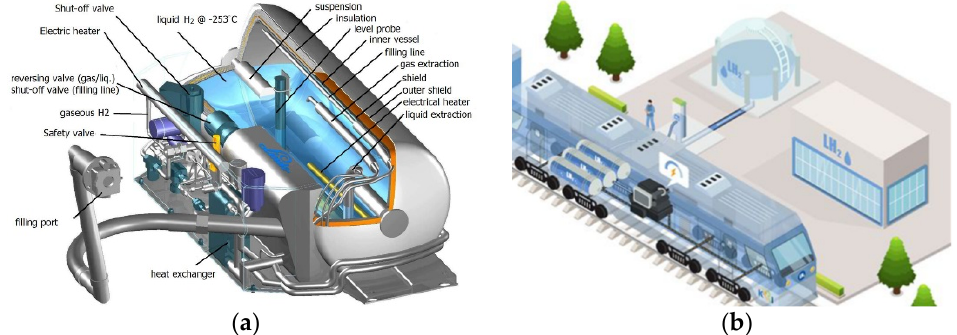
Figure 4. ( a ) Liquid hydrogen storage system from Linde [60] ; ( b ) Schematic of the LH 2 -hybrid train and the charging infrastructure presented by KRRI.